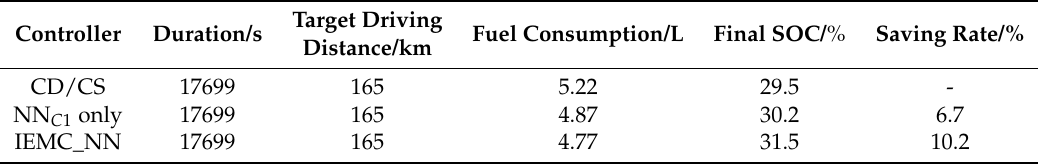
Table 4. Comparison of untrained driving distance fuel economy (NEDC cycle).